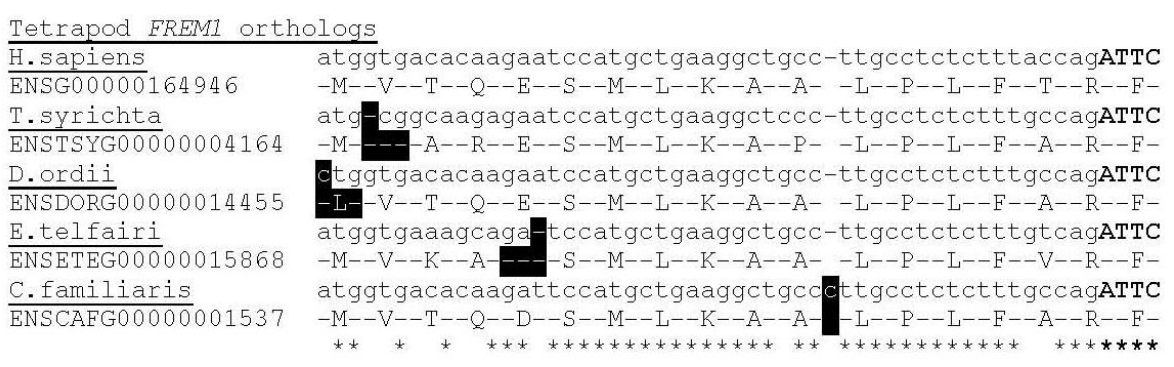
For C. familiaris , D. ordii , T. syrichta and E. telfairi , analysis of the nucleotide sequences and corresponding translations revealed that single base mutations (highlighted in black ) are responsible for non-homologous N -terminal sequences. H. sapiens TILRR is also shown for comparison. Figure 4. FREM1 orthologs in fish lack the TILRR N